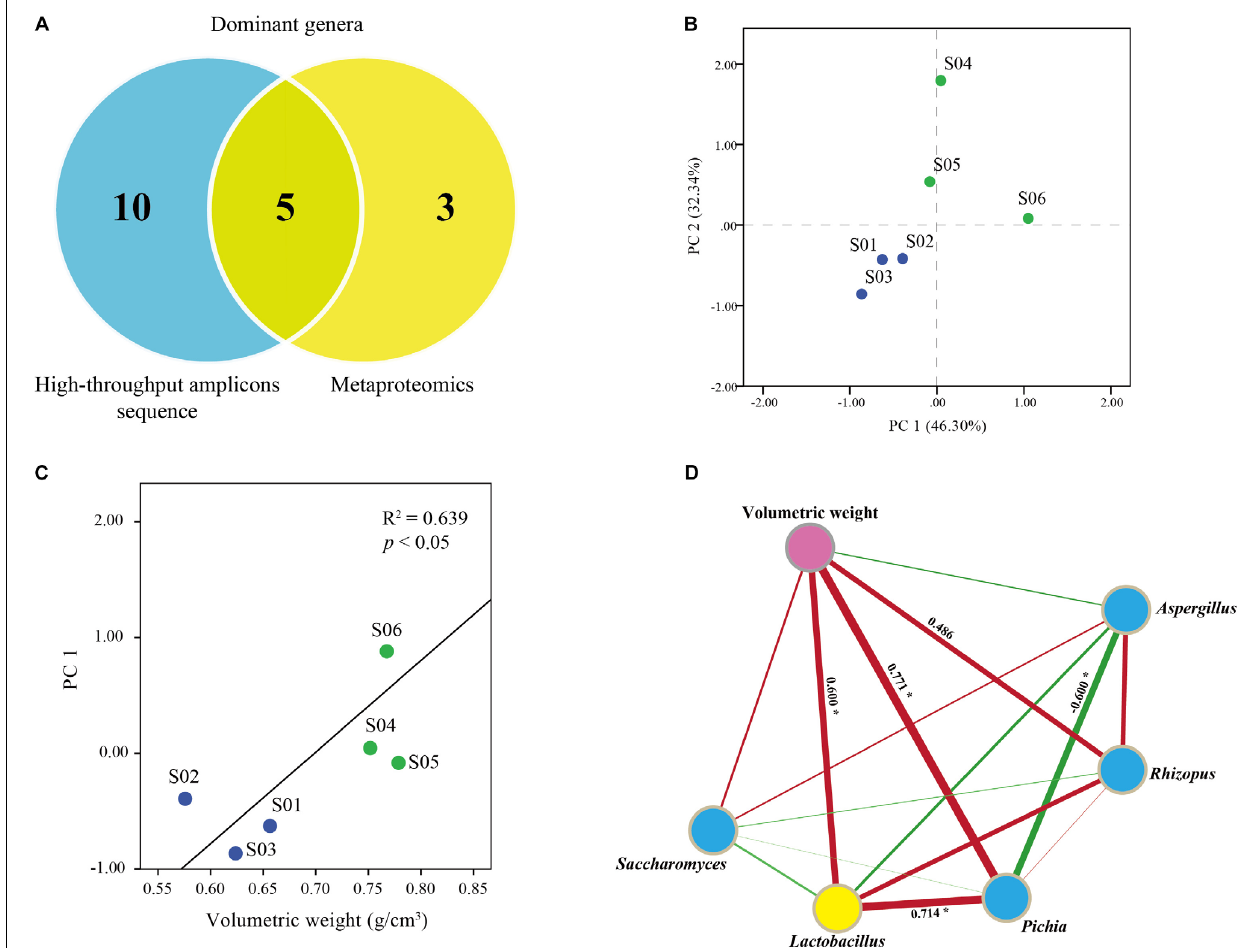
FIGURE 4 | (A) Core functional microbes identified in diffused and squeezed Jiuqu . (B) Amplicons analysis represented the similarities of core functional microbes based on principal component analysis (PCA). (C,D) Correlation network between microbiota and volumetric weight